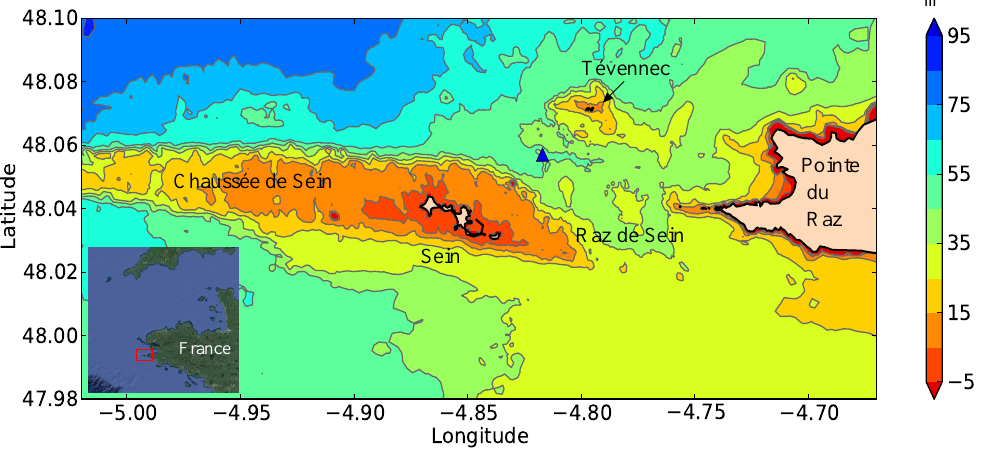
Figure 1. Spatial distribution of the mean water depth in the “Raz de Sein” with the location of the available measurement point (blue triangle).